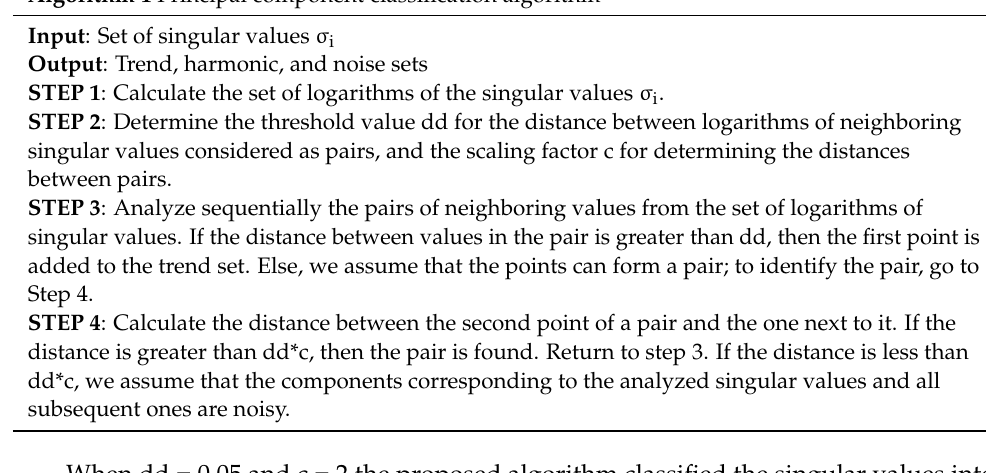
Algorithm 1 Principal component classification algorithm